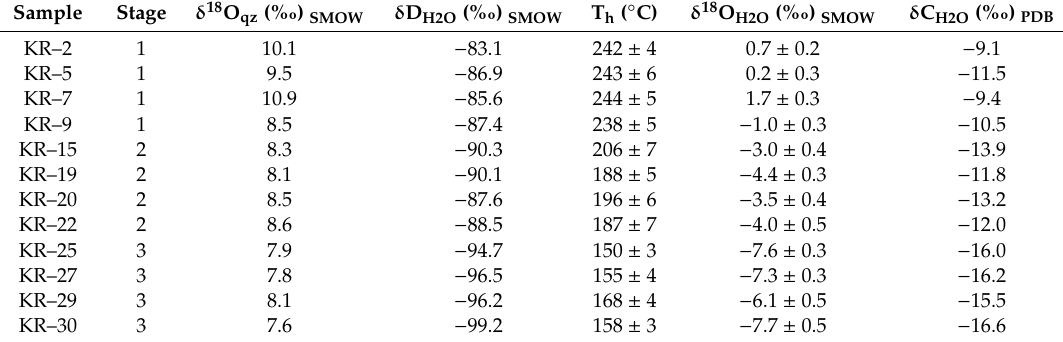
Table 2. Oxygen, hydrogen, and carbon isotope data from hydrothermal quartz of the Kuergasheng Pb–Zn deposit.